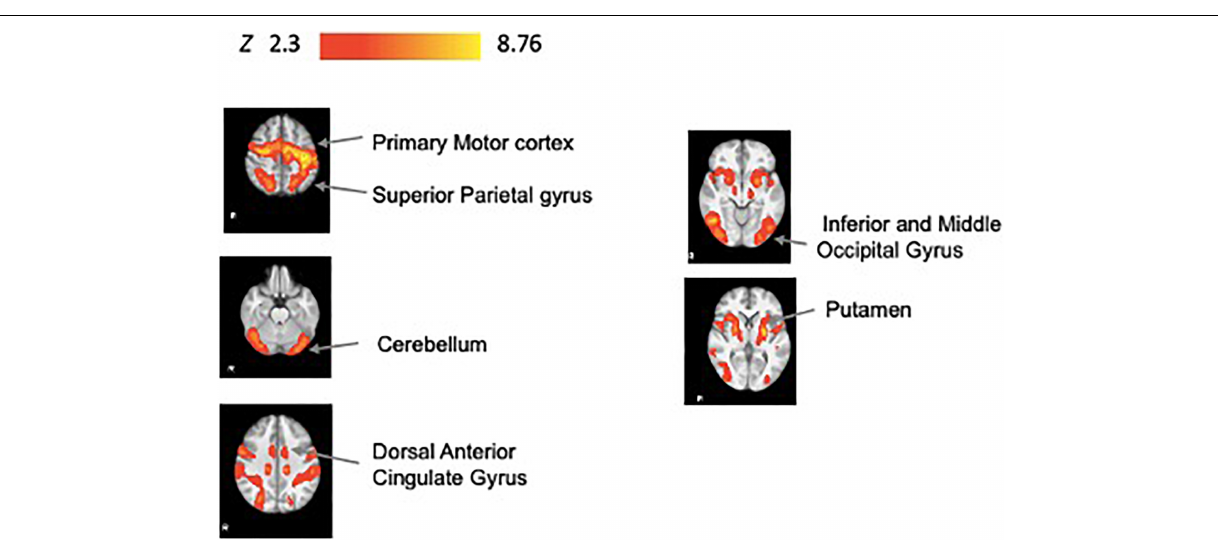
FIGURE 3 | Task-related fMRI activity. Brain activity associated with task period during practice ( N = 34). We show significant associations in the precentral gyrus, dorsal anterior cingulate gyrus, superior parietal gyrus, putamen, fusiform gyrus, inferior and middle occipital gyrus, and superior parietal gyrus. All results have been corrected for multiple comparisons ( p <